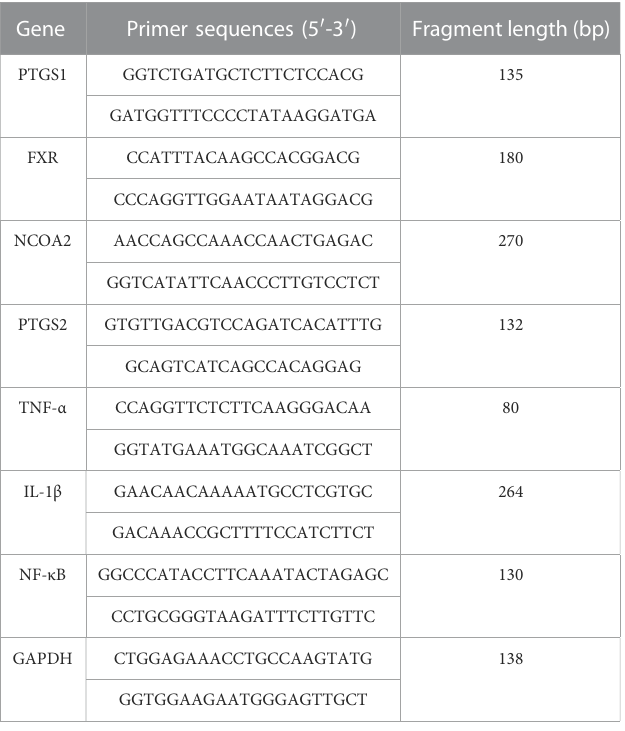
TABLE 1 Primers for real-time reverse transcription-polymerase chain reaction (RT-PCR). Gene Primer sequences (5 ′ -3 ′